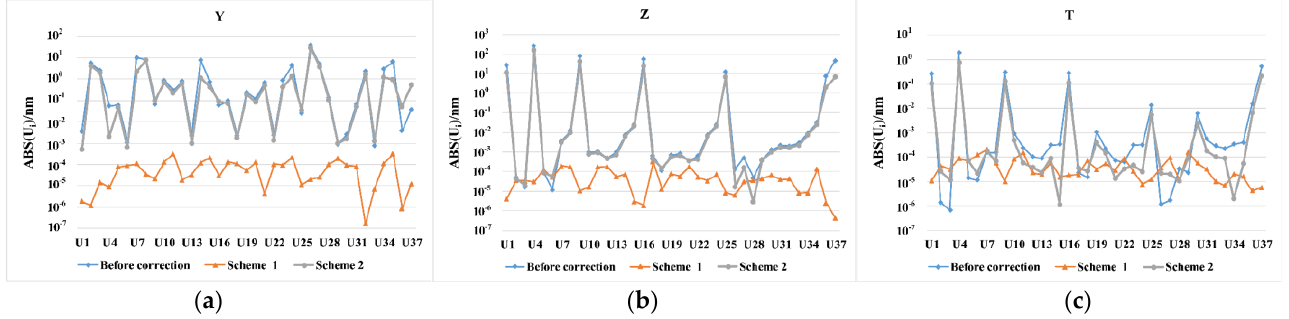
Figure 7. Comparison of residual aberration before and after correction of two schemes, ( a ) Com- parison of mirror aberration coefficients in the Y condition, ( b ) Comparison of mirror aberration coefficients in the Z condition, and ( c ) Comparison of mirror aberration coefficients in the T condi- tion.